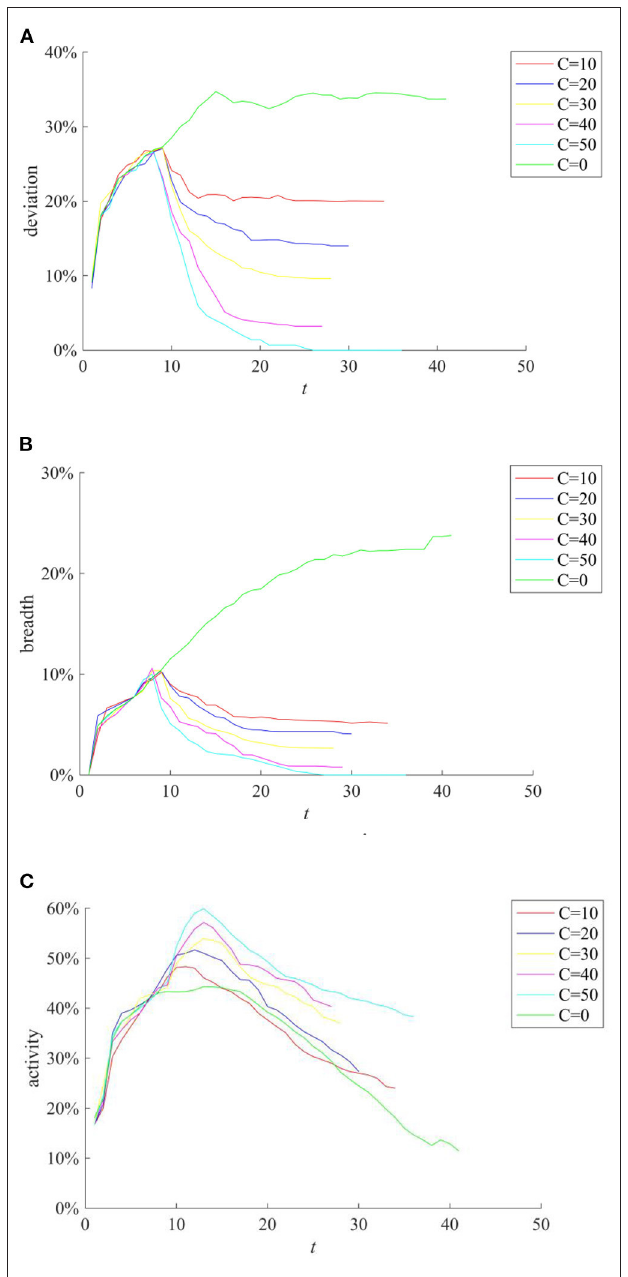
FIGURE 16 | The effect of rumor-refuting strategies based on different rumor time refuting interval. (A) Entire network information content deviation. (B) Rumor diffusion range. (C) Network